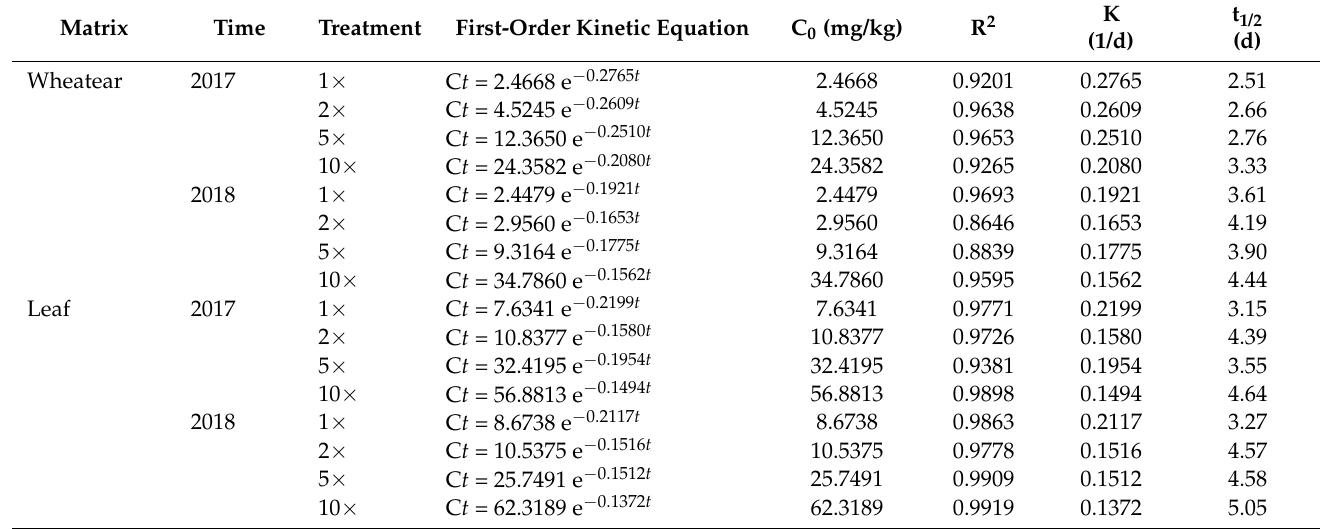
Table 4. Degradation kinetics of chlorpyrifos at different applied dosages in different parts of